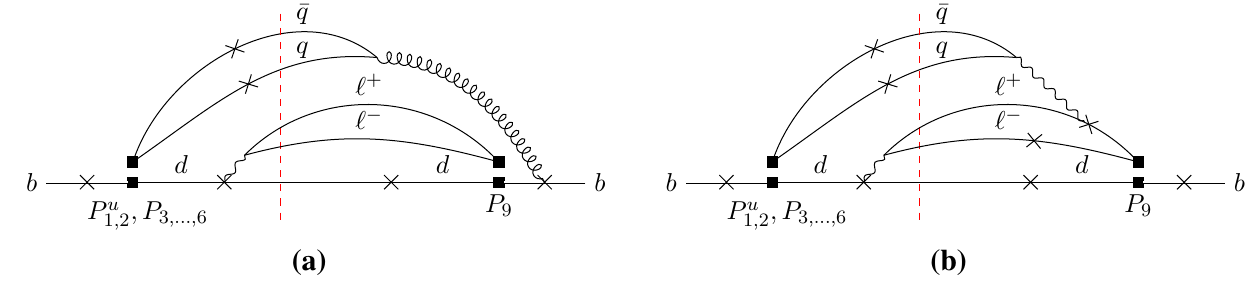
, P Fig. 2 Contributions of the P u 3 ,..., 6 interference with P 9 via ( a ) emission of the quark pair via a gluon (QCD) ( b ) emission of the quark pair 1 , 2 via a photon (QED). Again the photon or gluon can be emitted and absorbed from the different fermion lines as indicated by the crosses